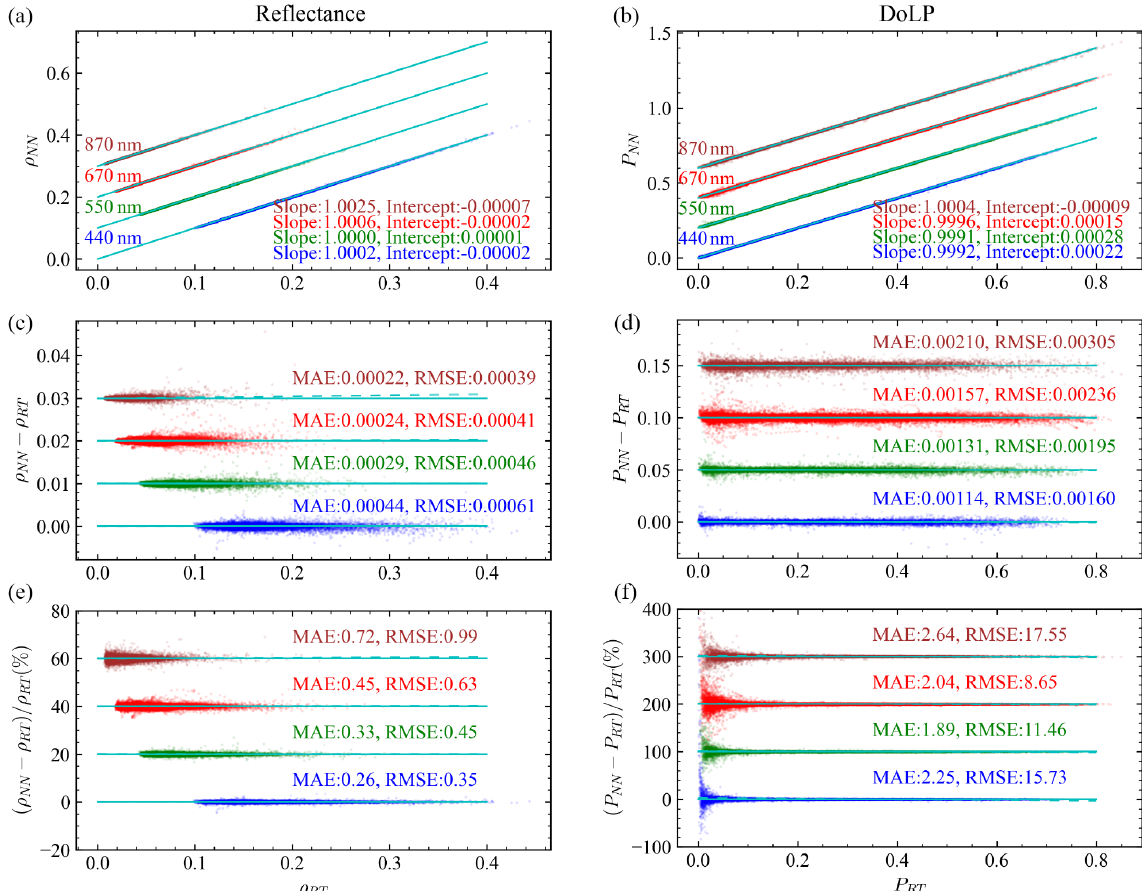
Figure 4. Comparison between the radiative transfer simulation and NN prediction: (a, c, e) reflectance ( ρ ) and (b, d, f) DoLP ( P ). The scatter plots are shown in panels (a) and (b) , the difference in panels (c) and (d) , and the percentage difference in panels (e) and (f) . For each plot, the data points for the 550, 660, and 870nm bands are shifted upward by constant offsets consecutively as indicated by the solid cyan